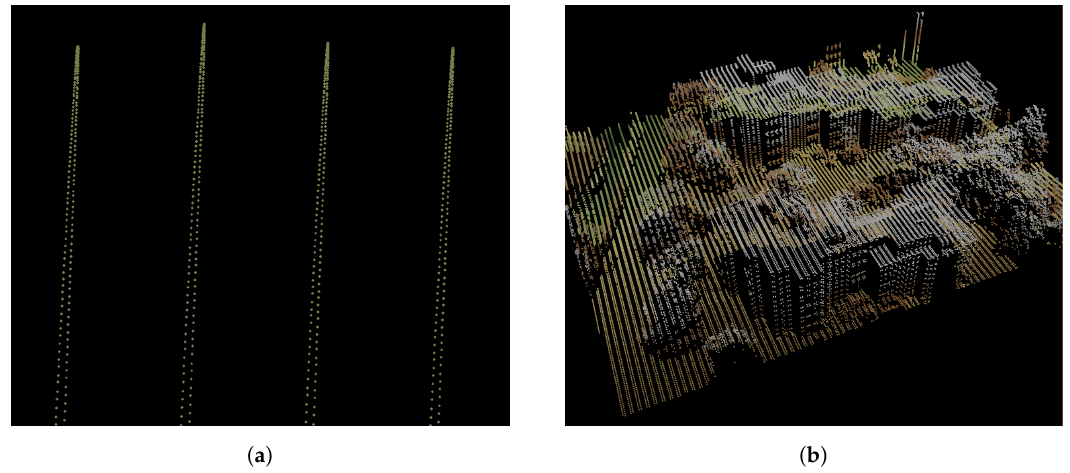
Figure 13. Sources of point accumulation: ( a ) oscillating mirror deceleration and ( b ) building facades.